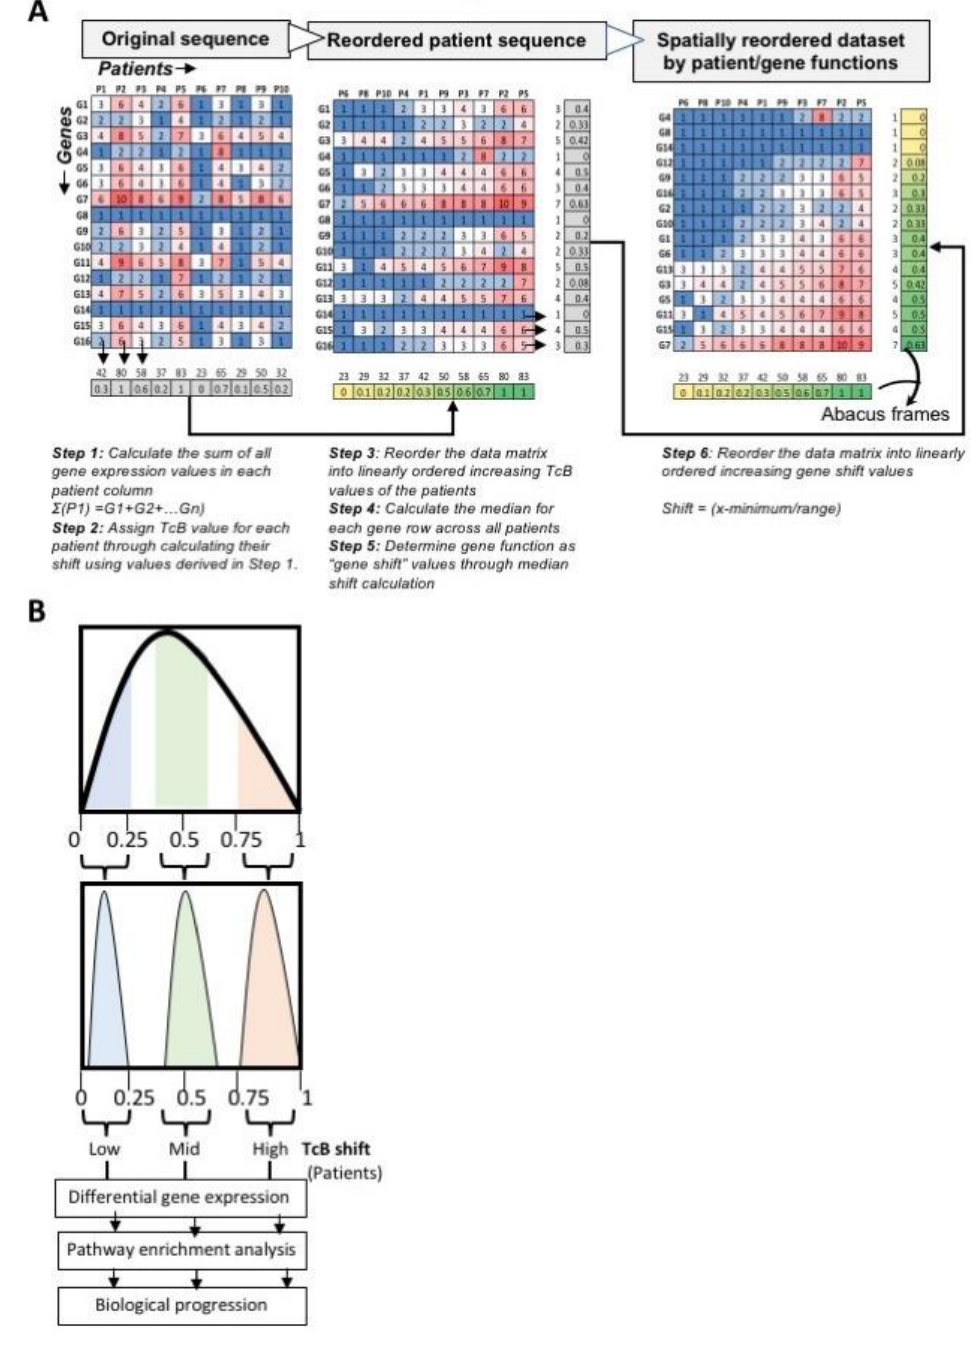
Figure 1. Deconvolution of stochastically ordered bulk RNAseq reads from transcriptomic datasets by abacus ordering strategy. ( A ) Schematic illustration of sequential steps involved in the calculation of transcriptomic burden (TcB) and the transformation of stochastically ordered gene expression data into linearly ordered dataset. ( B ) Theoretical distribution of gene expression and resolution by TcB with data partitioning criteria for patient grouping for downstream biological pathway enrichment analysis for discovering progressive patterns in gene